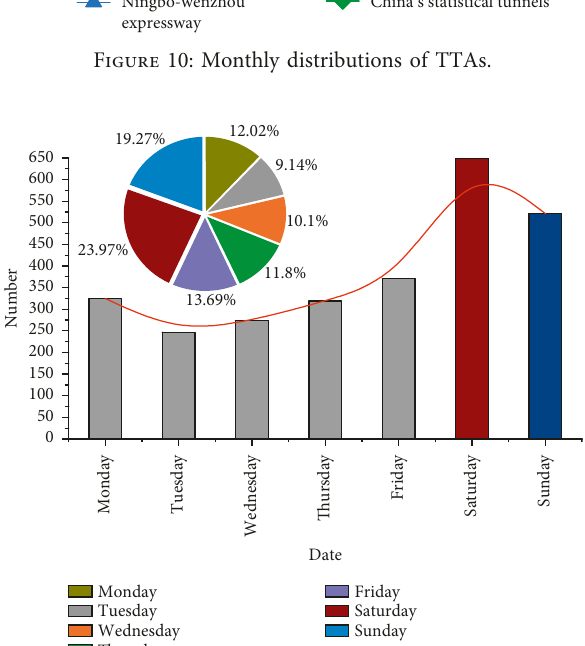
Figure 11: Weekly distributions of TTAs.